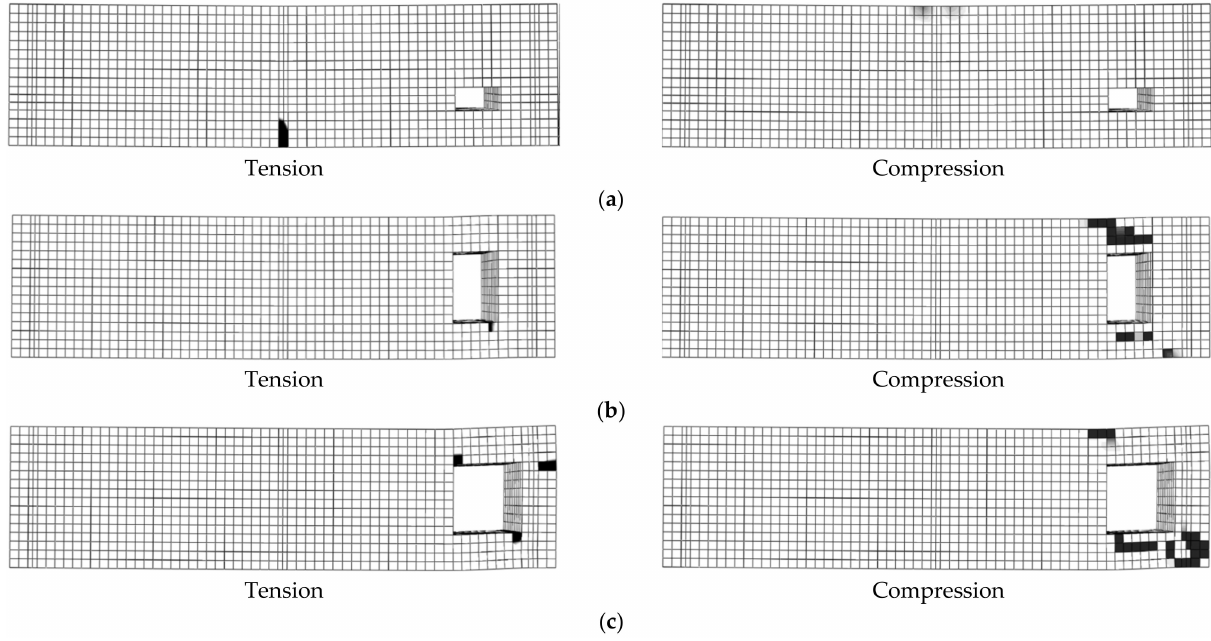
Figure 9. Failure modes of beams with transversal near support opening (group 2): ( a ) Beam B6-1; ( b ) Beam B6-3; ( c ) Beam B6-6. For simulated RC beams located in group 3 (with LH), as the opening height ( h 1 ) in- creased, the beam loads reduced. For beams with b 1 = 80 mm, the maximum values of µ cr , µ y